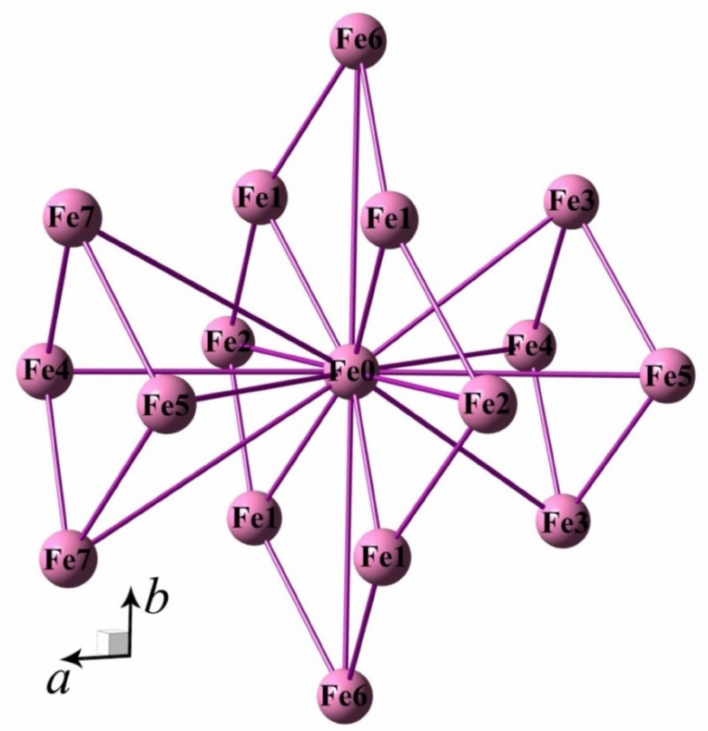
Figure 9. Crystal structure of LiFePO 4 : nearest neighboring magnetic ions for Fe 2+ . Distances between the iron ions are: Fe0–Fe1 = 3.863 Å; Fe0–Fe2 = 4.67 Å; Fe0–Fe3 = 5.428 Å; Fe0–Fe4 = 5.575 Å; Fe0–Fe5 = 5.79 Å; Fe0–Fe6 = 6.01 Å; and Fe0–Fe7 = 6.571